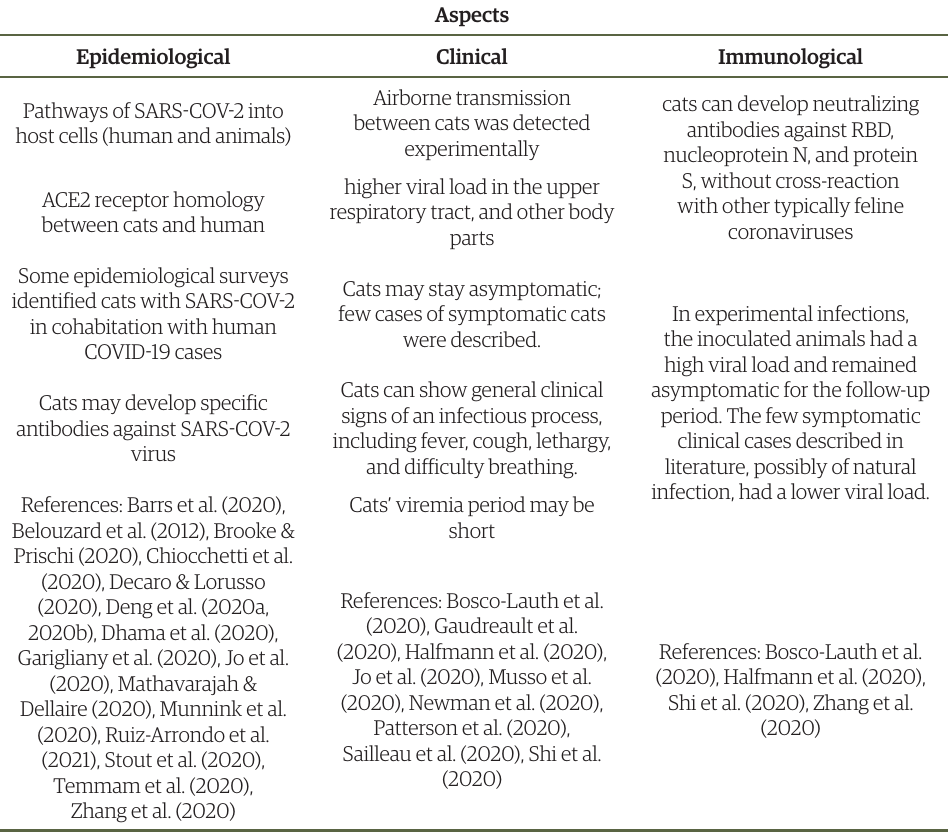
Table 1. Main scientific findings of cats with